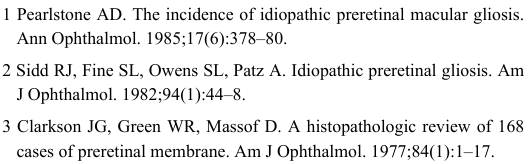
Table2: Detailed preoperative and postoperative status of the patients.